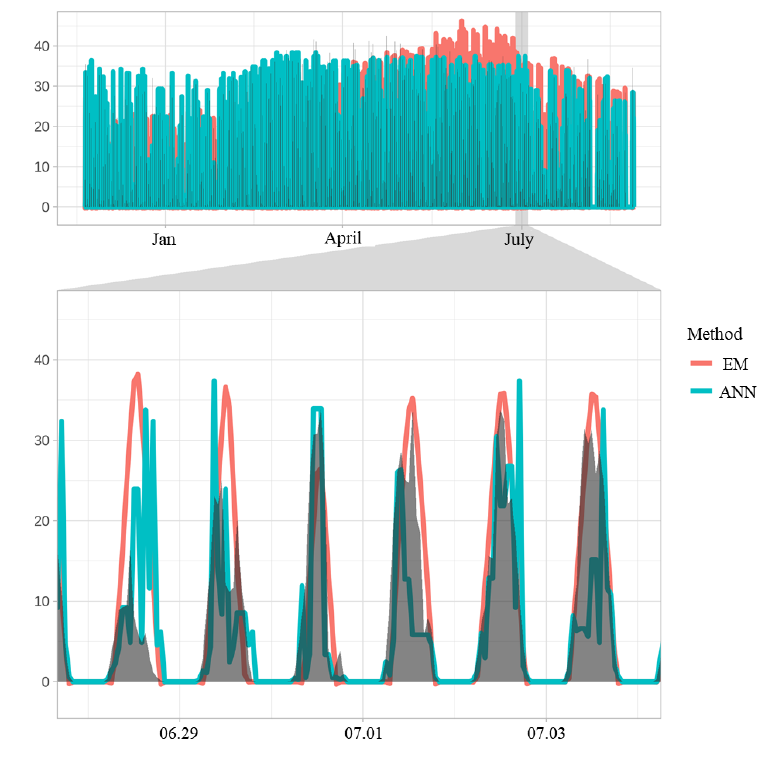
Figure 7. Comparison performances between EM and ANN. In Figure 7, the results of ANN and EM are represented in blue and red,